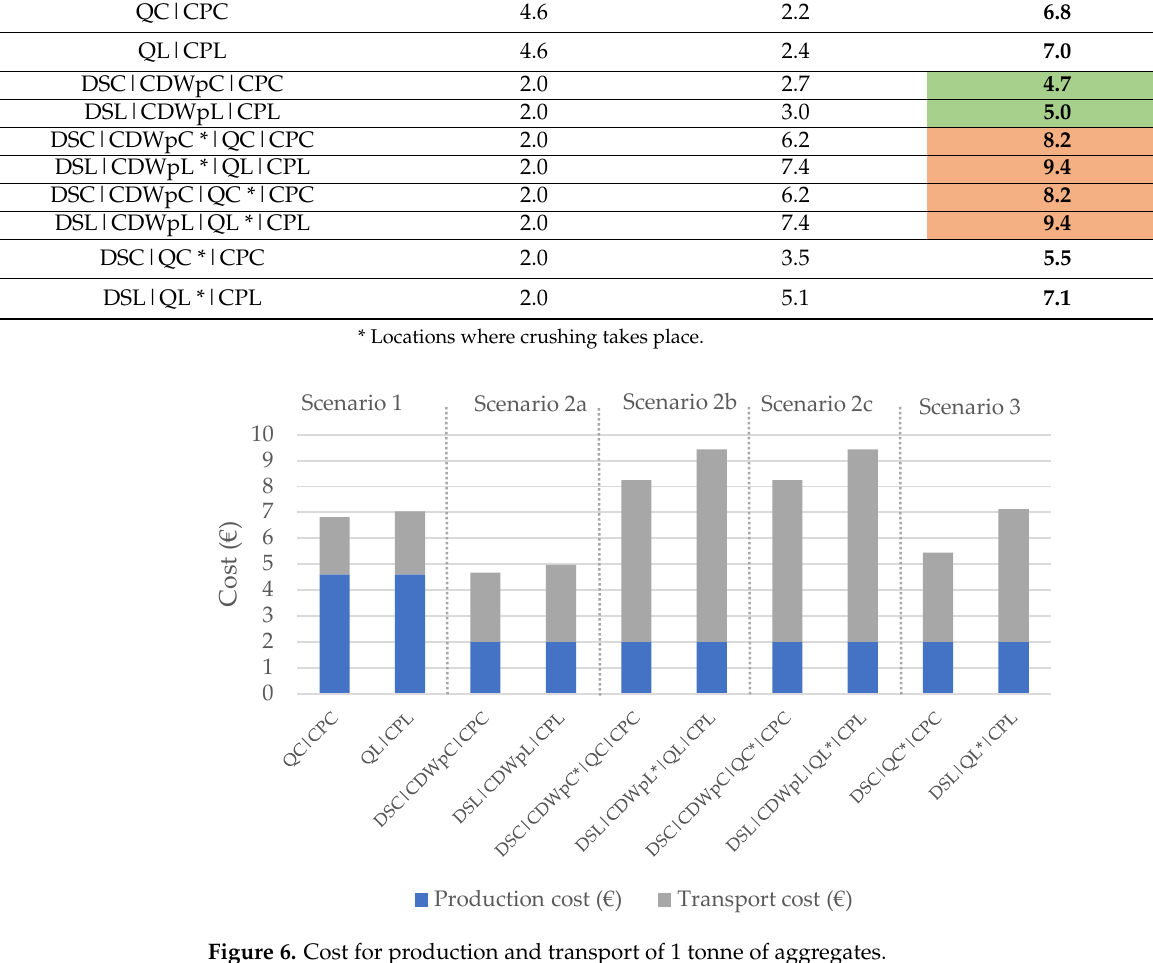
Figure 6. Cost for production and transport of 1 tonne of aggregates.